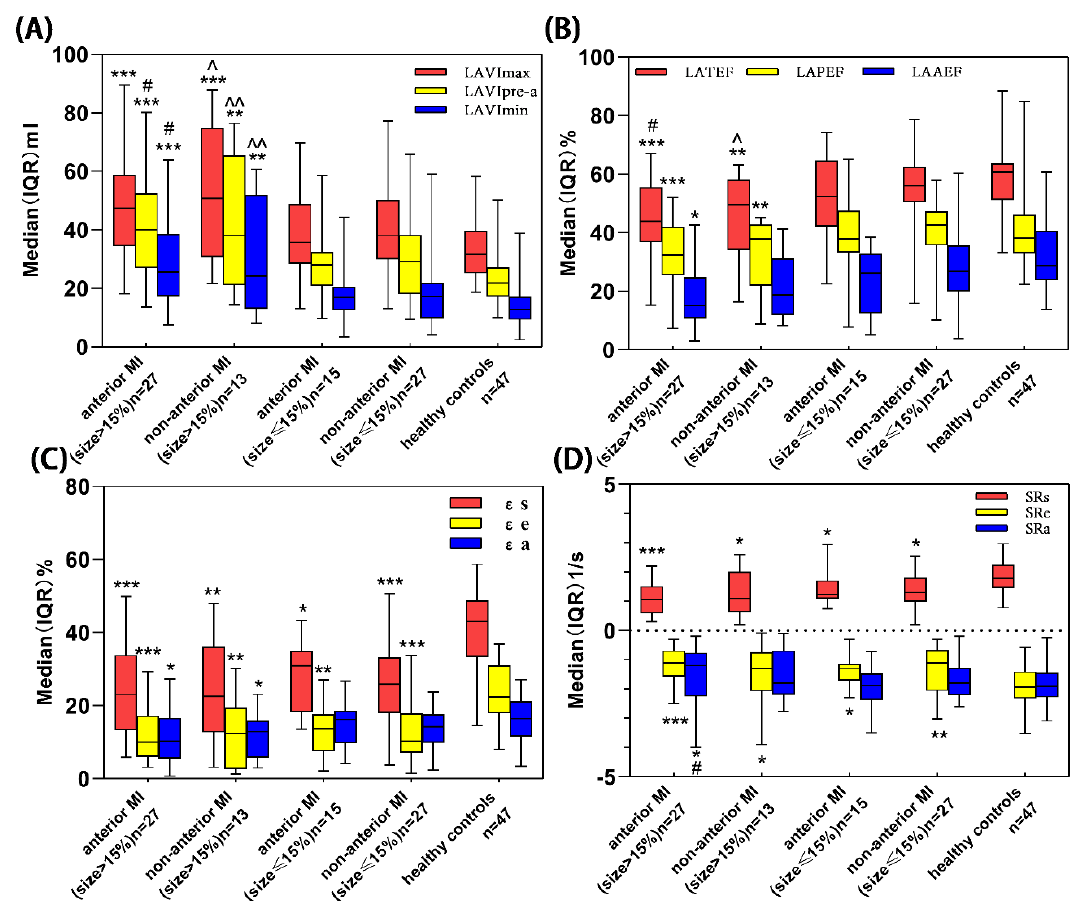
Figure 3. Kruskal–Wallis H was performed for comparisons of LA volume ( A ), LAEF ( B ), LA strain ( C ) and their corresponding strain rate ( D ) parameters among five groups (anterior MI (size > 15%), non-anterior MI (size > 15%), anterior MI (size ≤ 15%), non-anterior MI (size ≤ 15%) and healthy controls). 15% = median of MI size [8]. * p < 0.05 vs. healthy controls; ** p < 0.01 vs. healthy controls; *** p < 0.001 vs. healthy controls; ˆ p < 0.05 vs. non-anterior MI (size ≤ 15%); ˆˆ p < 0.01 vs. non-anterior MI (size ≤ 15%); # p < 0.05 vs. anterior MI (size ≤ 15%). LA = left atrial, MI = myocardial